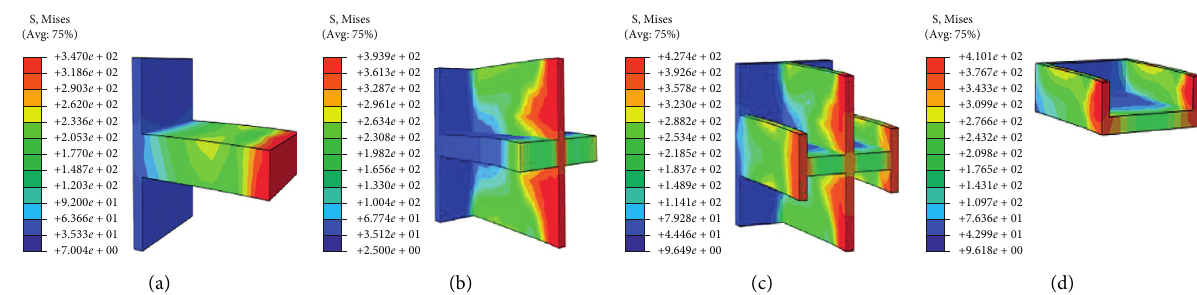
Figure 12: von Mises stress nephogram of shear connectors: (a) linear type; (b) cross type; (c) cross bilinear type (CB type); (d) channel type.